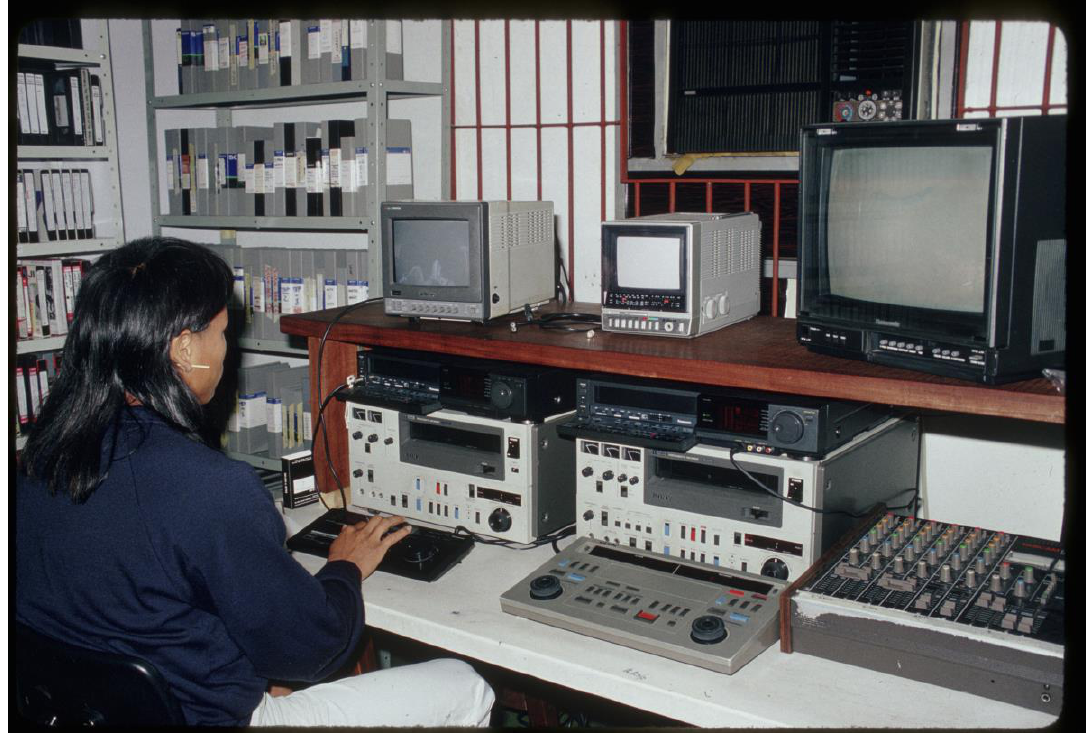
Figure 4 . Waiassé experiments with equipment at Video in the Villages. Source: Photo courtesy of Laura R. Graham